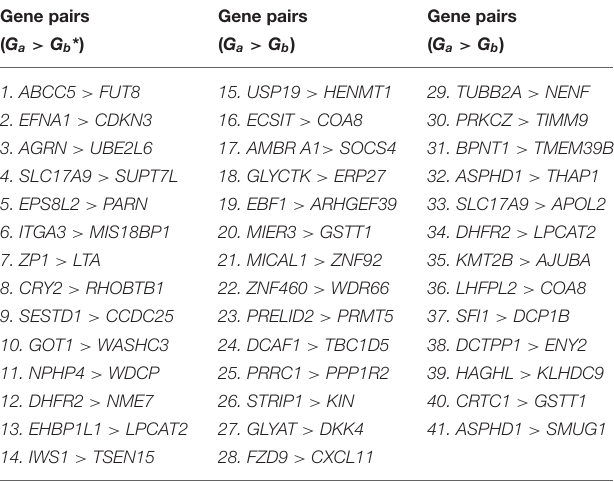
Frontiers in Medicine |